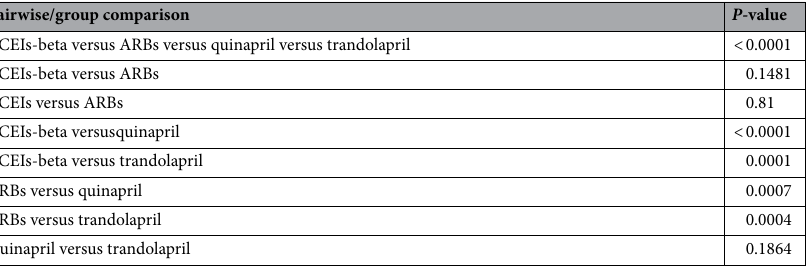
Table 1. The results of Friedman tests comparing seven pairwise/groups were calculated using ACEIs-beta, ARBs, quinapril, and trandolapril. ARBs angiotensin II receptor blockers, ACEIs-beta angiotensin-converting enzyme inhibitors excluding quinapril and